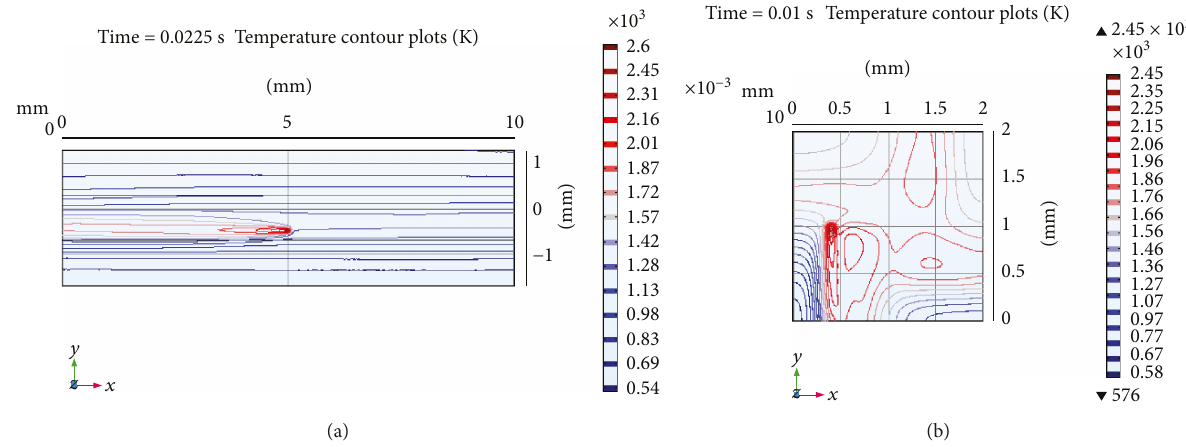
Figure 7: Temperature contour plots: (a) S-shaped scanning strategy and (b) island scanning strategy.